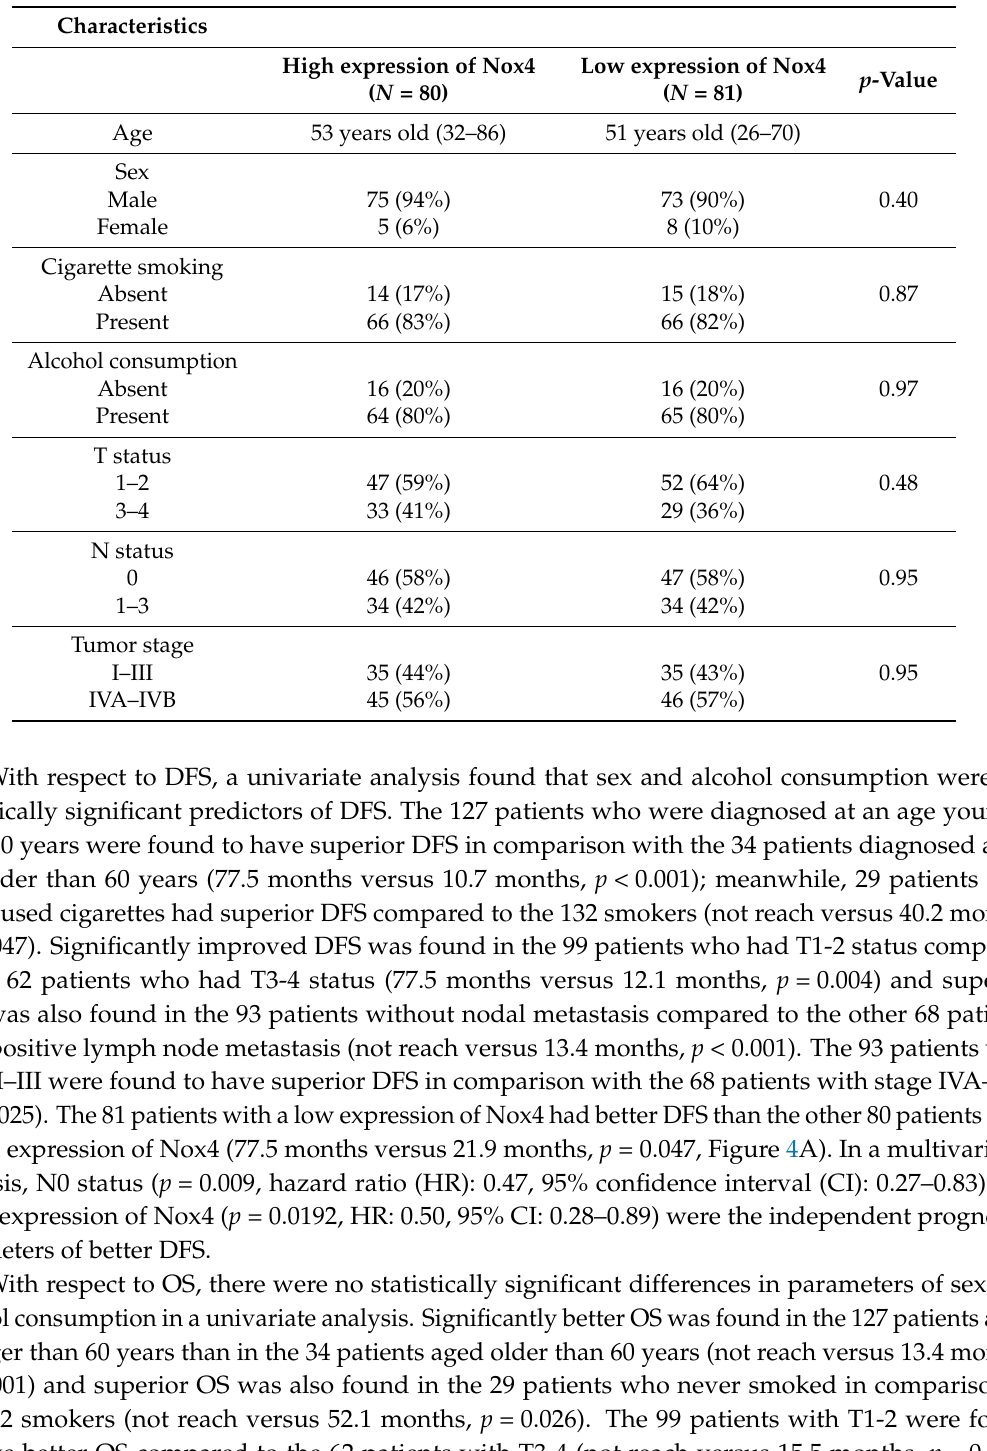
Table 2. Comparison of clinicopathological parameters in 161 patients with oral tongue squamous cell carcinoma receiving surgical